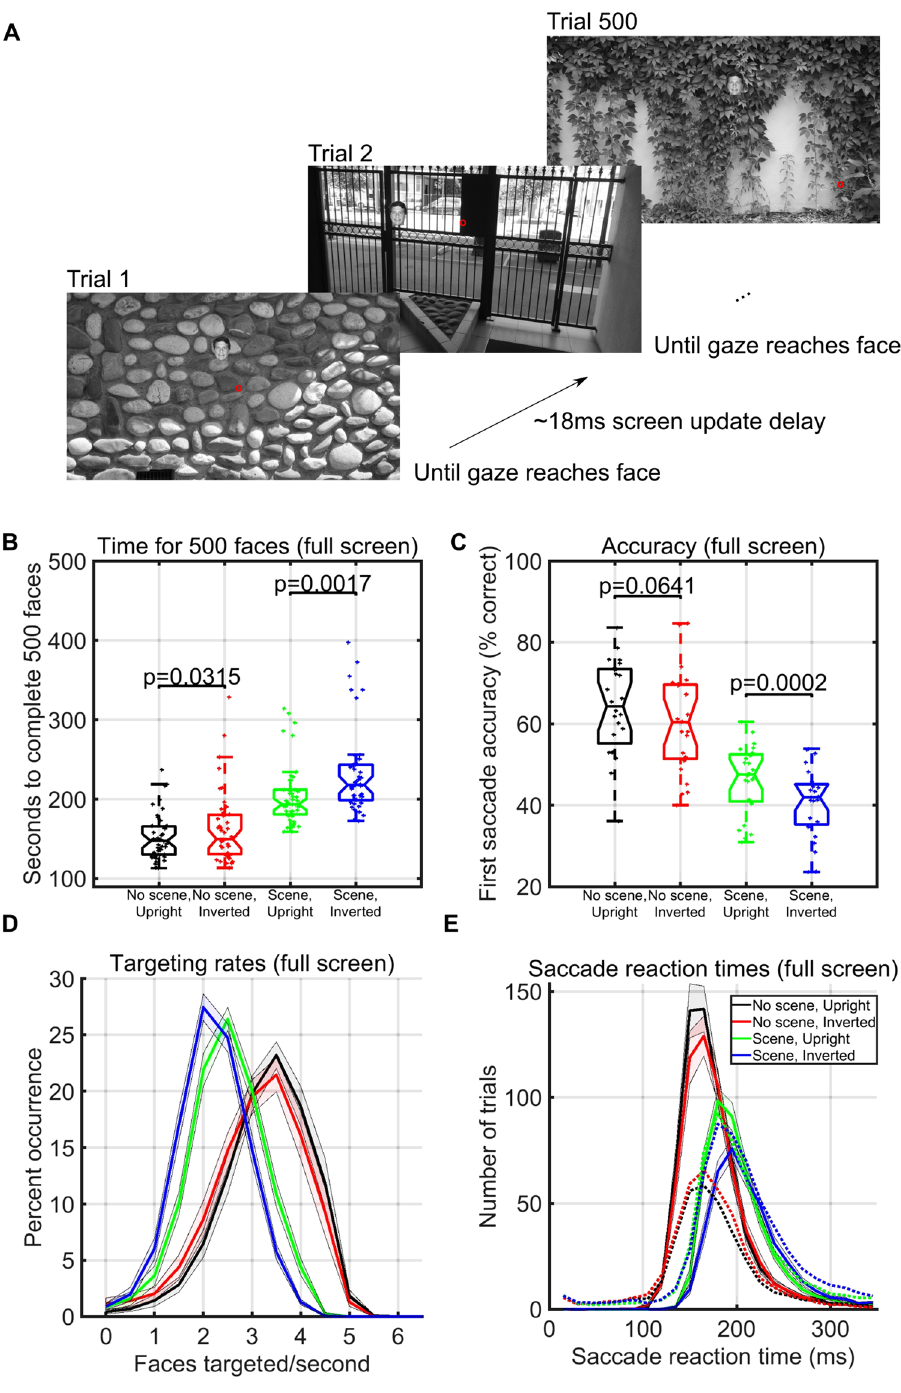
Figure 1. Paradigm and timing results over the entire screen (Experiment 1). ( A ) One block of 500 trials of the gaze-contingent continuous saccade detection paradigm with upright faces pasted on varying background scenes. The red circle represents the eye gaze location and did not appear during the experiment. The subject had to target the face with their gaze to proceed to the next trial. Locations of the 3° faces on each trial were independent from the previous trial and appeared at any location on the screen. Faces shown are for illustration, but all experiments used different faces in each trial of each block. ( B ) Boxplots of the number of seconds required, including blinks and all eye-movement times, to complete 500 3° faces in each condition over 24 subjects in Experiment 1. Individual dots are the time taken to complete a single counterbalanced block of 500 faces in each particular condition for each subject. ( C ) Percentage of trials in which the first saccade after stimulus onset landed within a 3° × 3° square surrounding the face (see Methods), for each condition. Shaded areas represent the standard error of the mean over the 24 subjects. ( D ) Percent occurrence of achieving a given rate of face detection speed (including all successes, mistakes, blinks, and eye movements) according to each condition (calculated over all possible sequences of 6 faces for each of the 24 subjects in the experiment). ( E